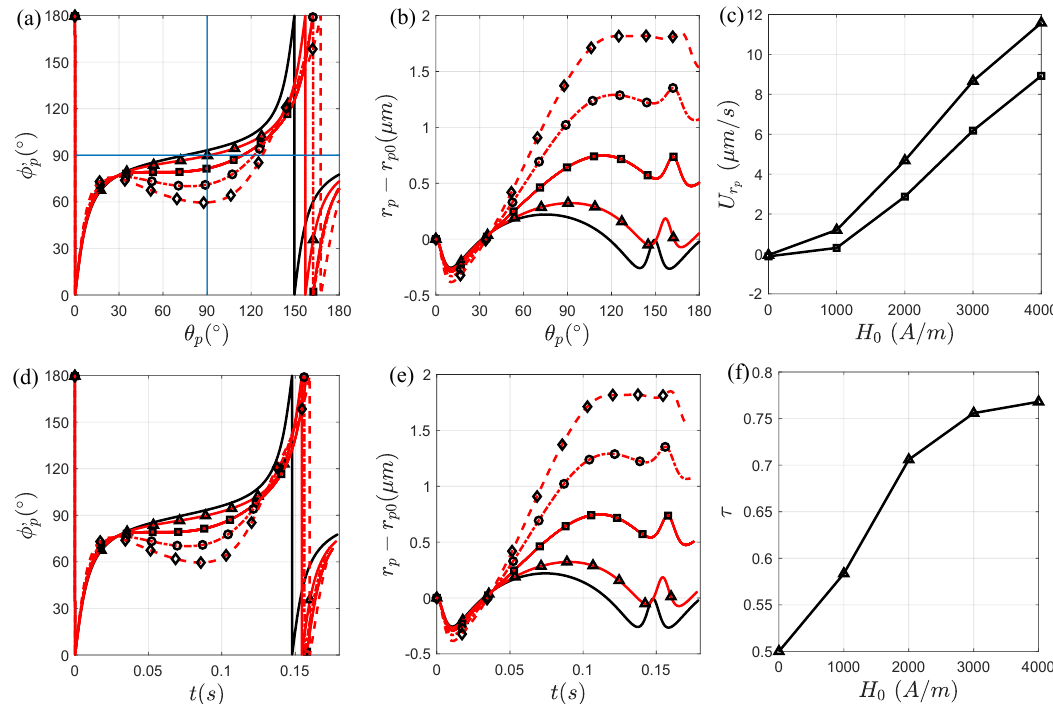
Figure 3. Effect of the magnetic field strength when it is applied at α = 0 ◦ . The particle ( AR = 4) is affected by the magnetic field when its center of mass is approximately at θ p = 0 ◦ in ( a , d ) when its rotation is with respect to θ p and time, respectively, for, H 0 = 0 A/m (solid black line), H 0 = 1000 A/m (triangle symbol), H 0 = 2000 A/m (square symbol), H 0 = 3000 A/m (circular symbol), and H 0 = 4000 A/m (diamond symbol). The radial particle-wall distance change of the particle with respect to ( b ) θ p , and ( e ) time. ( c ) The radial velocities of the particle U rp (triangle symbol) and U r θ (square symbol) as functions of H 0 . ( f ) The dimensionless parameter τ as a function of H 0 . We see that as τ increases, the net migration of the particle